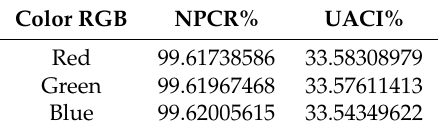
Table 6. NPCR and UACI differential attacks of Lena RGB encrypted using Rössler